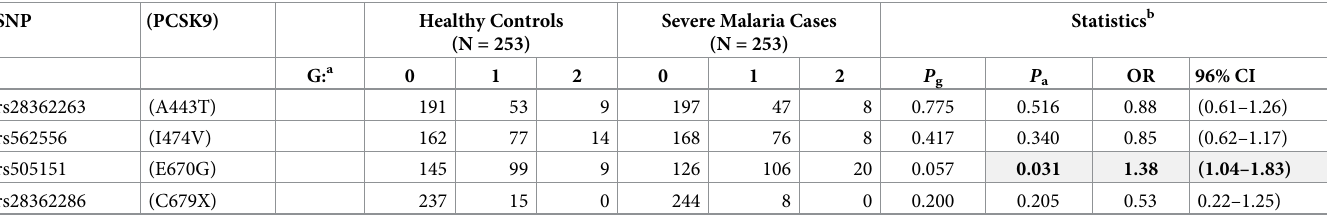
Table 3. Association analysis of PCSK9 SNPs and severe malaria.